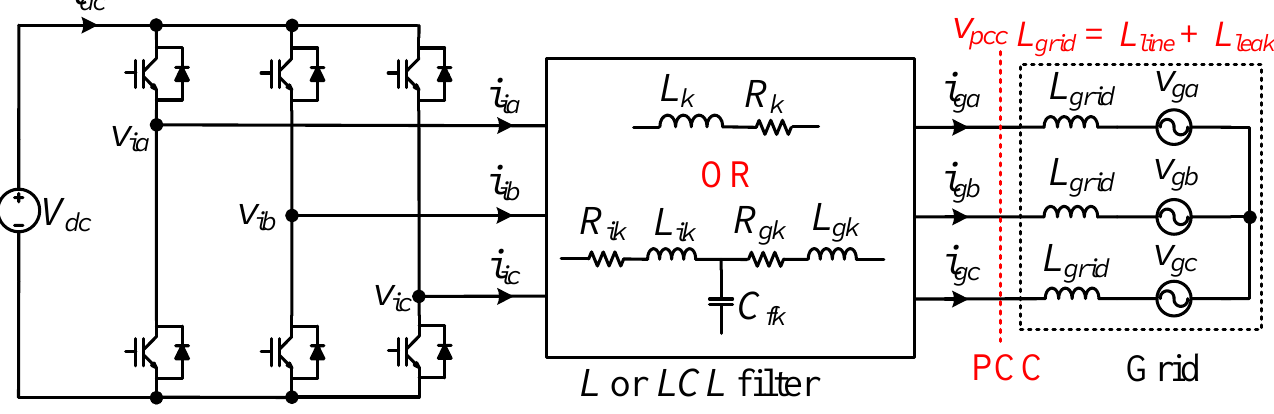
Figure 1. Three-phase GcI with L or LCL filter.